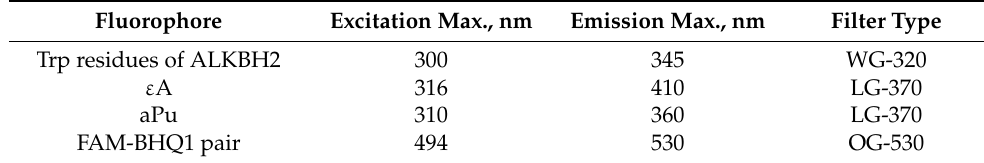
Table 3. A summary of fluorescent probes used in the study. Fluorophore Excitation Max., nm Emission Max., nm Filter Type Trp residues of ALKBH2 300 345